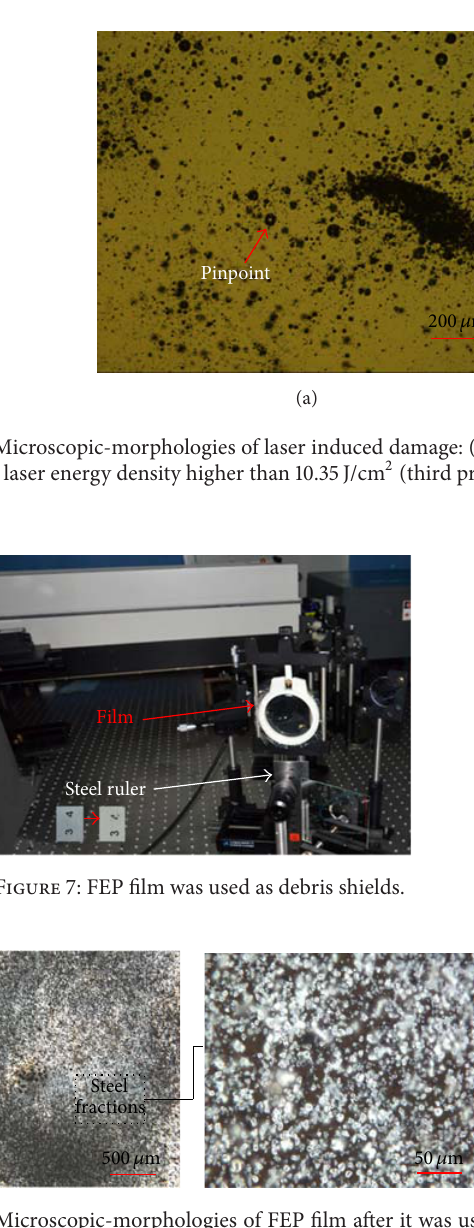
Figure 8: Microscopic-morphologies of FEP film after it was used as debris